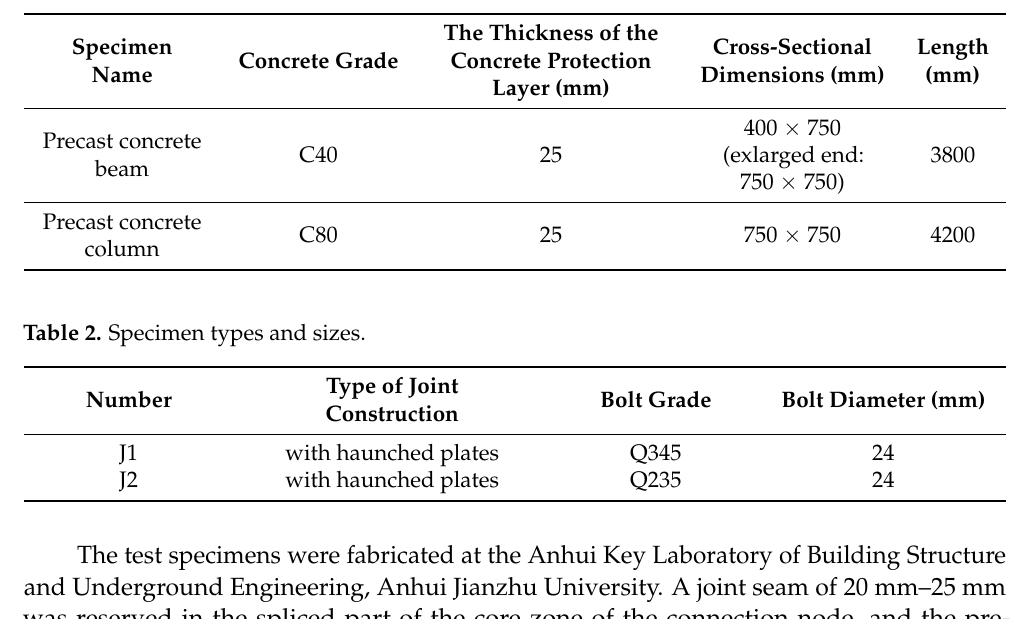
Table 1. Details of precast specimens.